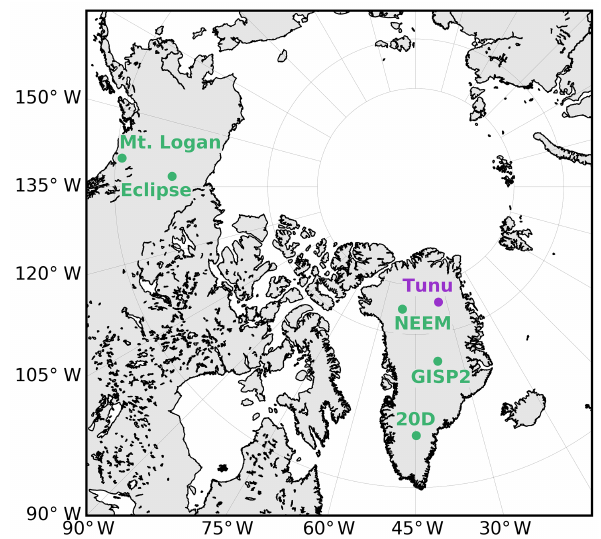
Figure 1. Tunu (78.04 ◦ N, 33.88 ◦ W; this study), the North Green- land Eemian Ice Drilling (NEEM) (77.49 ◦ N, 51.2 ◦ W), GISP2 (72.2 ◦ N, 37.8 ◦ W), 20D (65.01 ◦ N, 44.87 ◦ W), Eclipse Icefield (60.51 ◦ N, 139.47 ◦ W), and Mt. Logan (60.58 ◦ N, 140.58 ◦ W) ice core drilling sites (Sigl et al., 2015; Whitlow et al., 1994; Yalcin et al., 2006; Zennaro et al.,